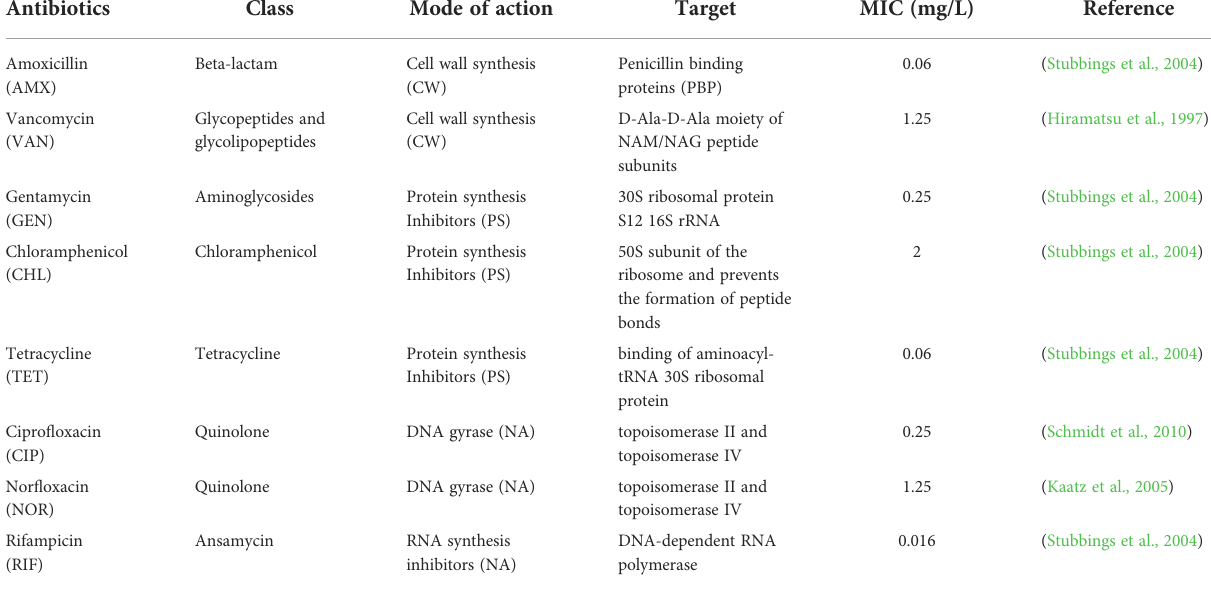
TABLE 1 Information of antibiotics and MIC of Staphylococcus aureus NCTC